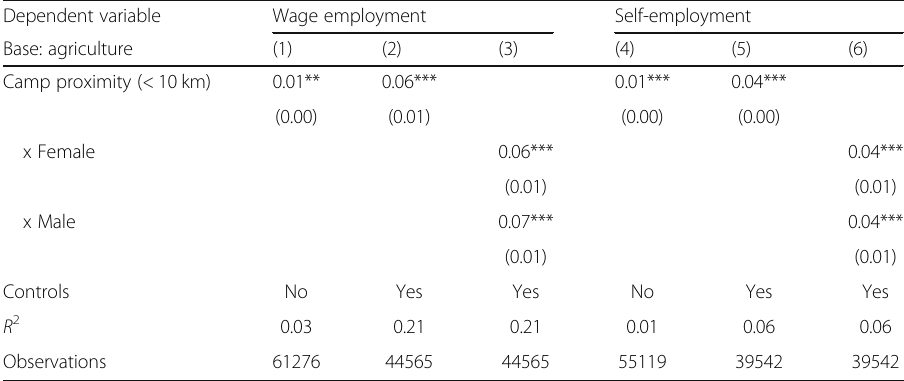
Table 15 Employment activity, using 2012 census data Dependent